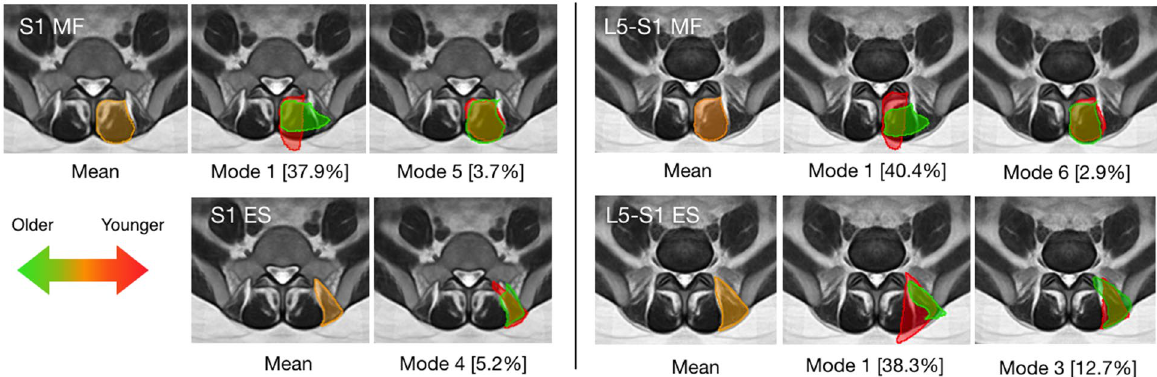
Figure 5. Modes of the multifidus (MF) and erector spinae (ES) shape that were associated with age. The mean shape is shown in orange overlaid on population-averaged MRI templates. The trend of shape variation towards an older age is in green and the opposite is in red. For each mode, threefold standard deviations from the mean shape are depicted for both directions of shape variants, and the percentages of shape variance explained are included in [ ] for all modes.